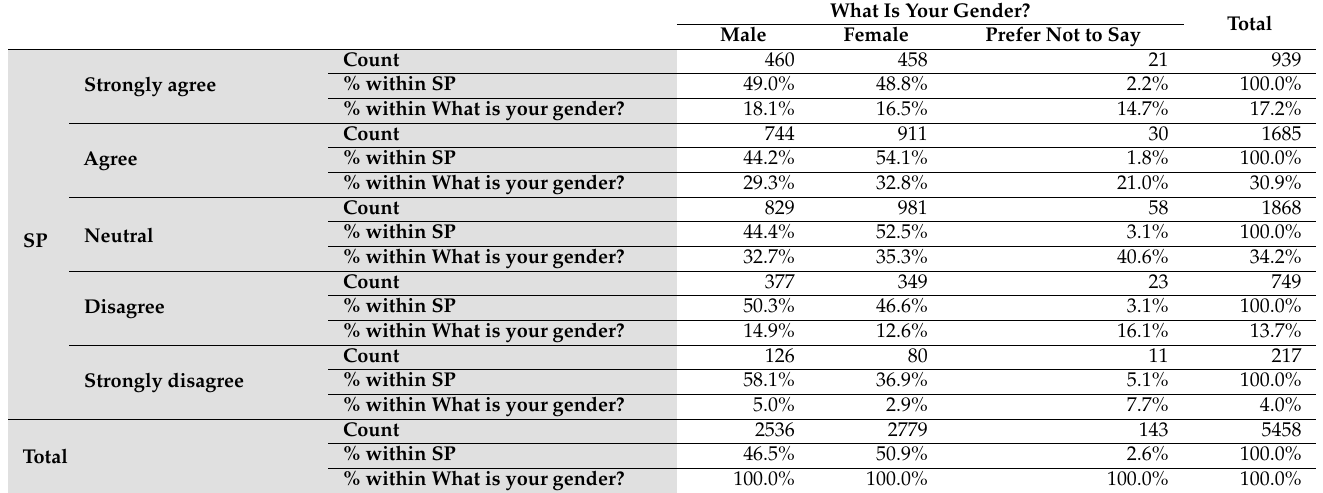
Table 10. Symbolic private value of EVs and respondents’ gender